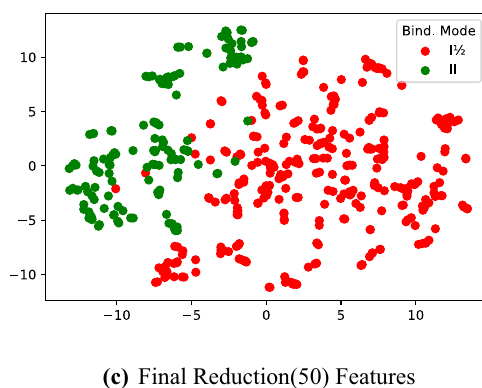
I 1 2 . ( a ) All: 4135 features, ( b ) combined −